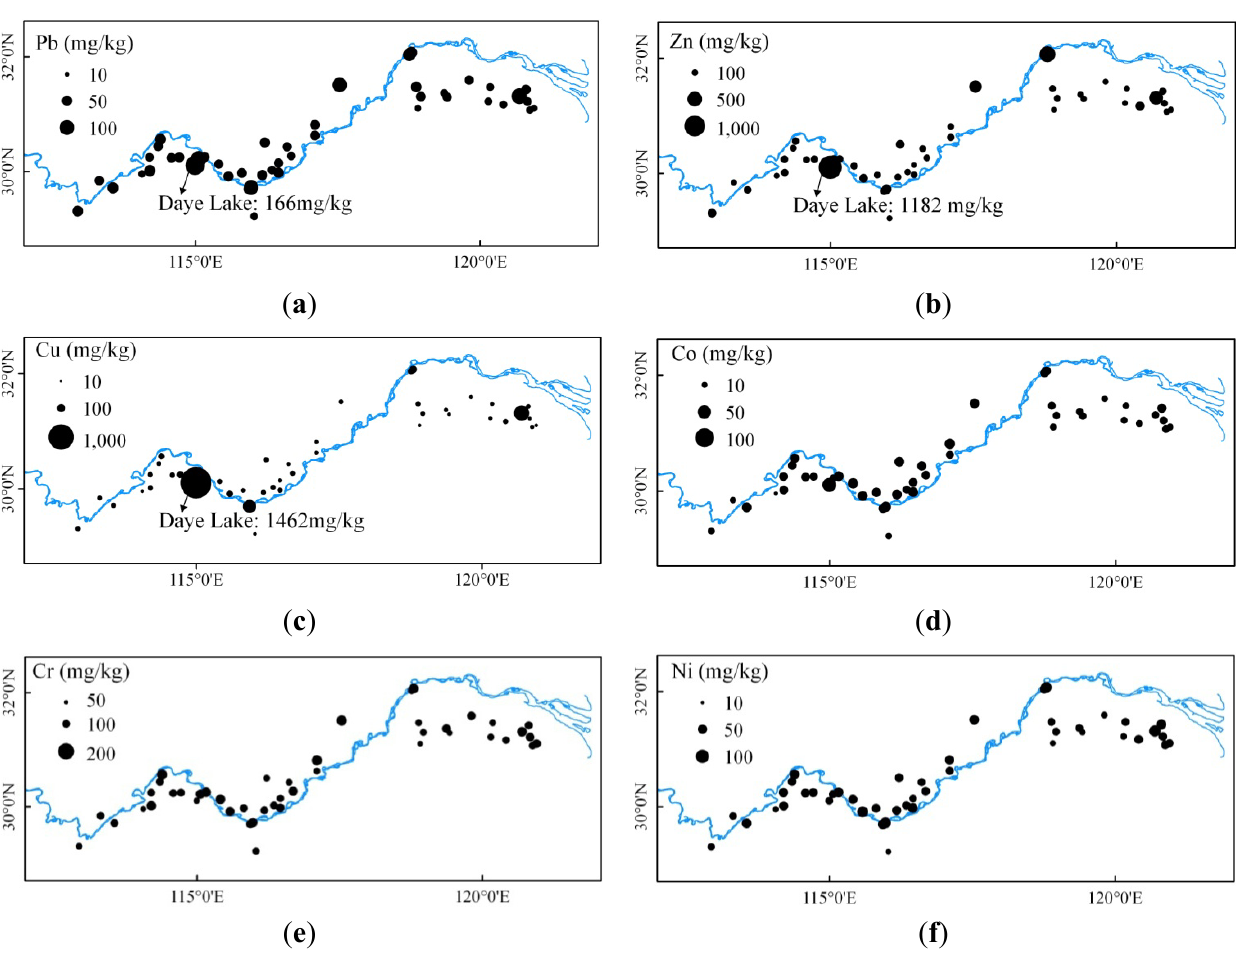
Figure 4. Spatial distribution of heavy metals of the lakes along the middle and lower reaches of Yangtze